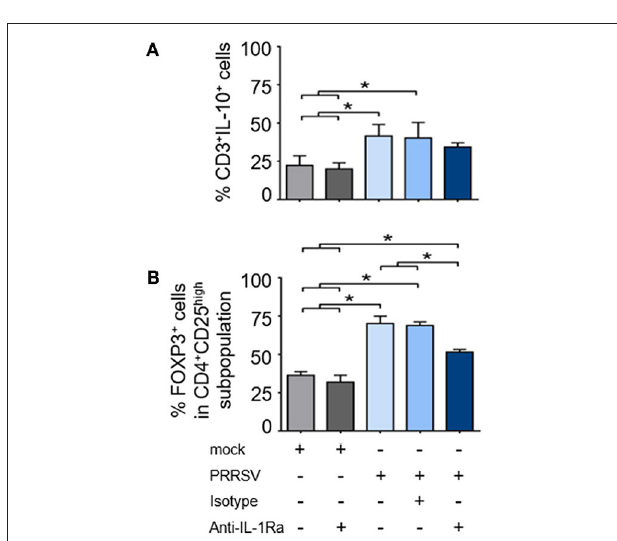
FIGURE 6 | PRRSV-induced IL-1Ra was partially involved in regulatory T lymphocyte (Treg) induction. PRRSV-induced IL-1Ra decreased numbers of (A) Treg, (B) but not IL-10-producing T lymphocytes. PBMC were cultured in the presence of type 2 PRRSV or mock. Subsequently, anti-IL-1Ra Ab was added into the culture and further incubated for 48h. ± indicates presence/absence of indicated treatment within the culture. Data represents mean ± SD from 5 pigs. Statistical significance was analyzed using ANOVA followed by Tukey’s test. * indicates significant difference at p <